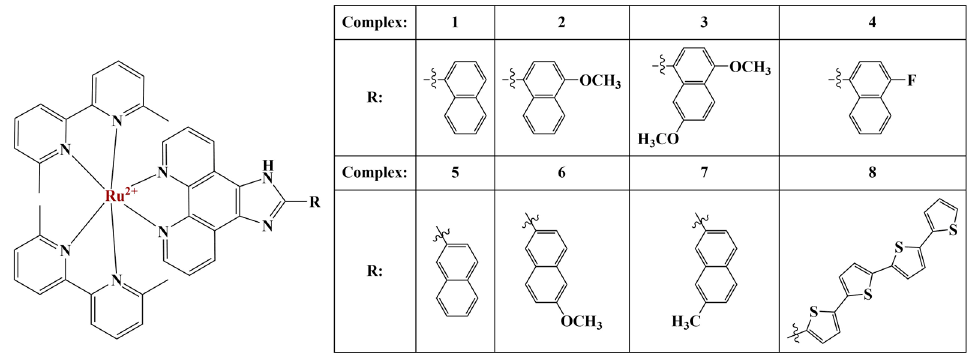
Figure 11. The complexes described by